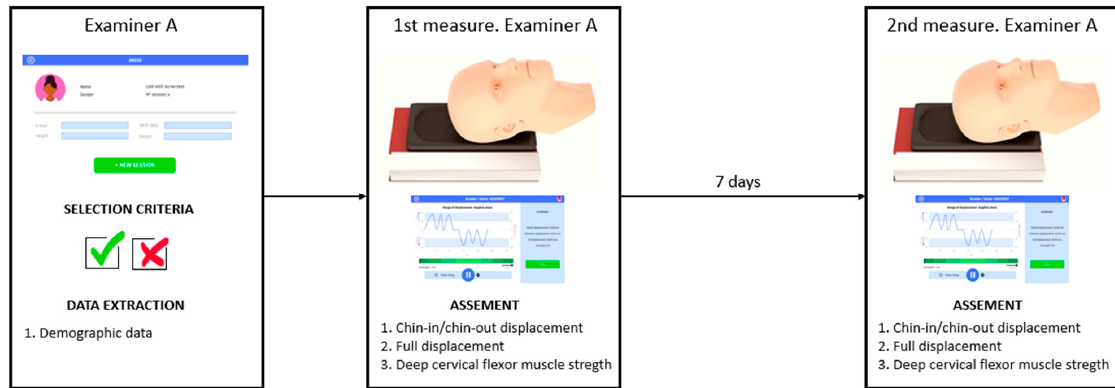
Figure 3. Flowchart of the study protocol .